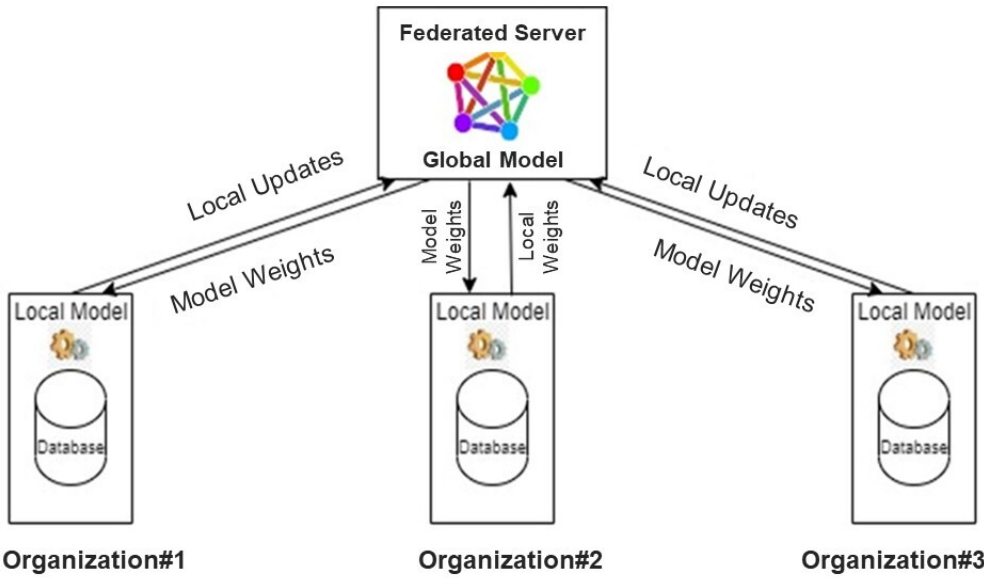
Figure 1. Flow chart of the federated learning model.